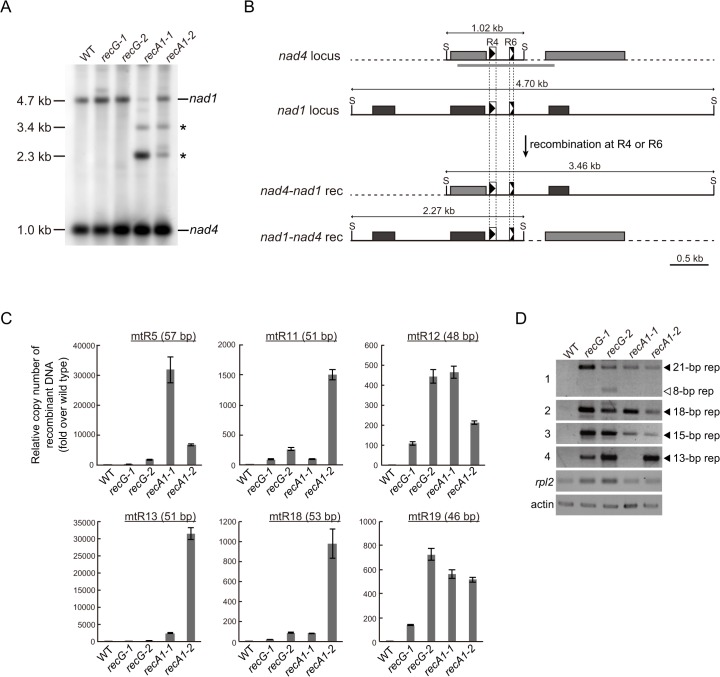
Genomic instability in RECG and RECA1 KO mitochondria.
A. mtDNA configuration at the nad4 locus. DNA from WT, RECG KO, and RECA1 KO strains digested with SacII were probed with nad4 probe. The asterisks denote signals corresponding to DNA recombined between nad4-nad1 repeats. The length of the bands is indicated on the left. B. Schematic explanation of the DNA structures detected in (A). Reciprocal recombination at R4 (90 bp) or R6 (56 bp) at nad4 and nad1 loci produces both nad4-nad1 rec and nad1-nad4 rec products. The SacII recognition sites are indicated by S. The positions of the probes used in (A) are indicated by thick gray lines. For details of the scheme, see legend of Fig. 5B. C. The amount of DNA generated by recombination between several direct repeats 46 to 57 bp in length. Relative copy number of DNA resulting from recombination between direct repeats (R5, R11, R12, R13, R18, or R19) per mitochondrial rpl2 DNA was measured by qPCR. WT was given a value of 1. The data represent mean of three replicates ± SD. All the RECG KO and RECA1 KO values are significantly different from WT values (p<0.01). D. DNA generated by recombination between short (<35 bp) repeats. PCR reaction numbers indicated on the left correspond to those in S1 Table. Mitochondrial gene rpl2 and nuclear gene actin were amplified as a control. Filled and blank triangles indicate DNA with the expected and unexpected sizes, respectively.